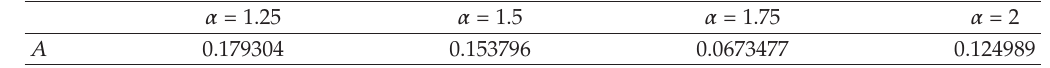
Table 3: Value of A for di ff erent values of α .